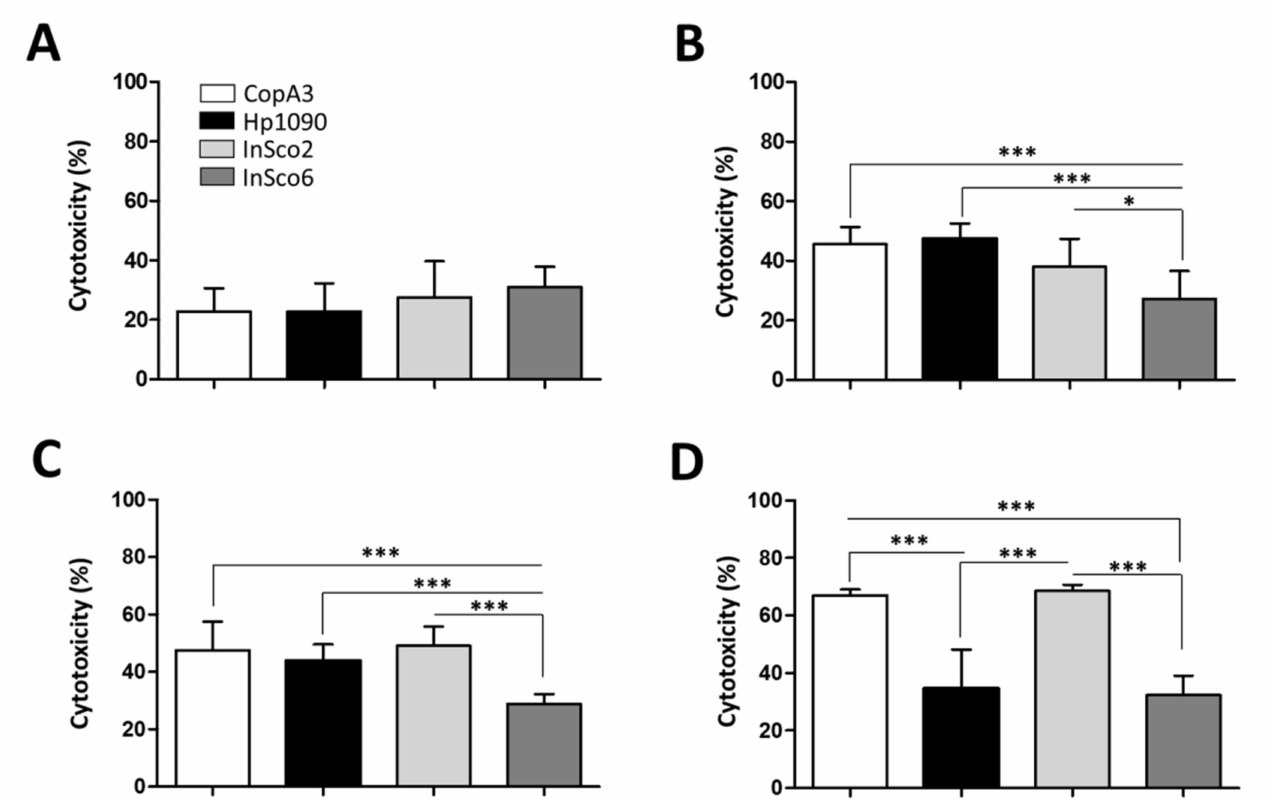
Figure 5. Cytotoxicity profile of the parental and hybrid AMPs. BHK-21 cells were incubated with the four AMPs to evaluate their cytotoxicity at four concentrations: ( A ) 0.1 µ M, ( B ) 1 µ M, ( C ) 10 µ M and ( D ) 100 µ M. Results were compared by one-way ANOVA with Tukey’s multiple comparison test applied for individual comparisons (significant differences between AMPs are indicated as follows: * p < 0.05; *** p <